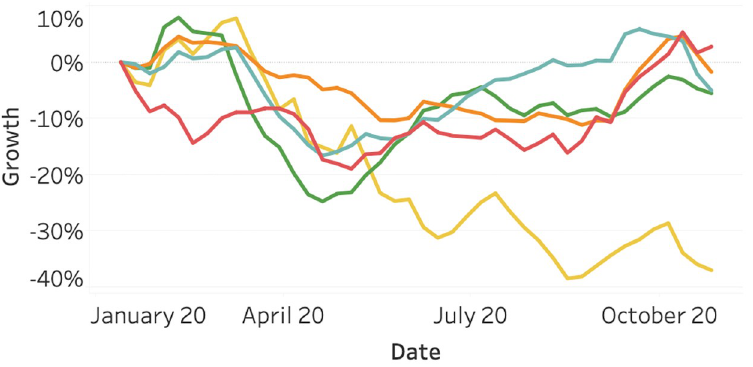
Fig 1. Vessel activity as of January 2020, split per continent. Port enters and exits are included in the data to account for intercontinental ships, exiting one continent and entering another. North America (orange), South America (yellow), Asia (red), Europe (light blue), and Oceania